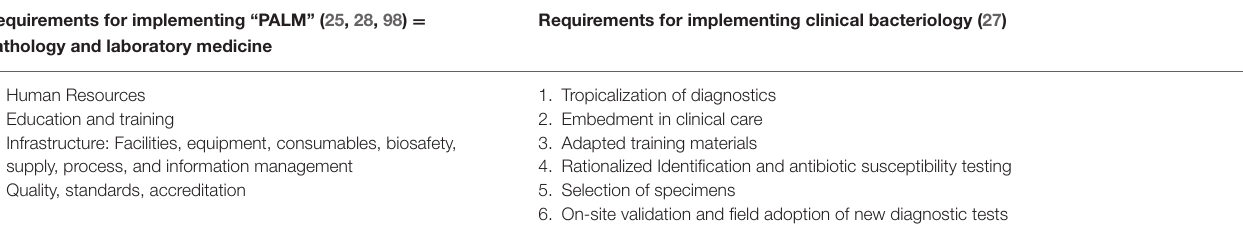
TABLE 4 | Challenges and needs for implantation of Clinical Bacteriology Laboratories at the hospital level in low resource settings, specifically in Sub-Saharan Africa. Requirements for implementing “PALM” (25, 28, 98)